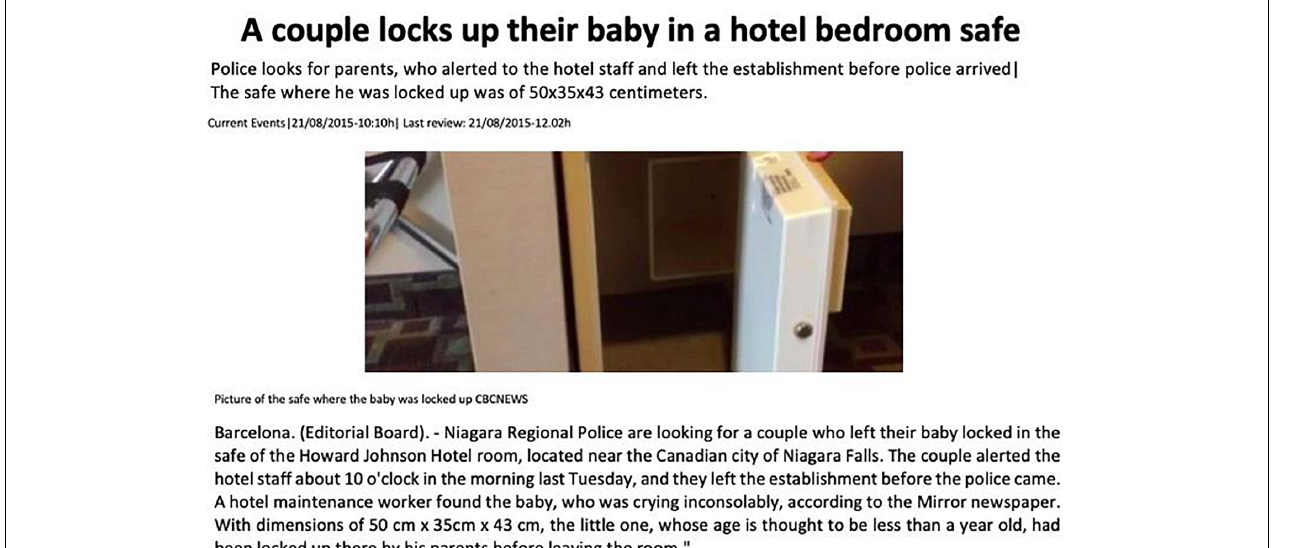
FIGURE 1 | Figure in the questionnaire, translated and